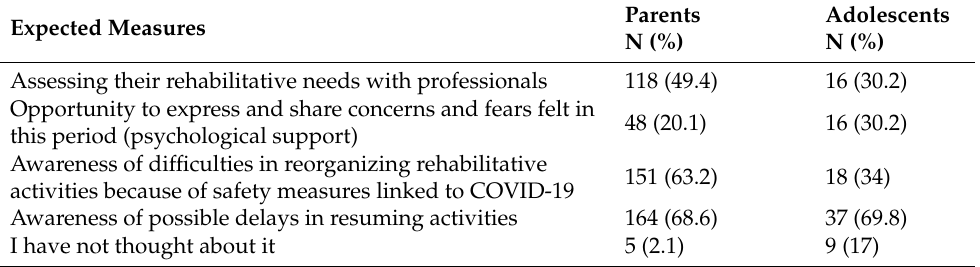
Table 8. Measures expected after